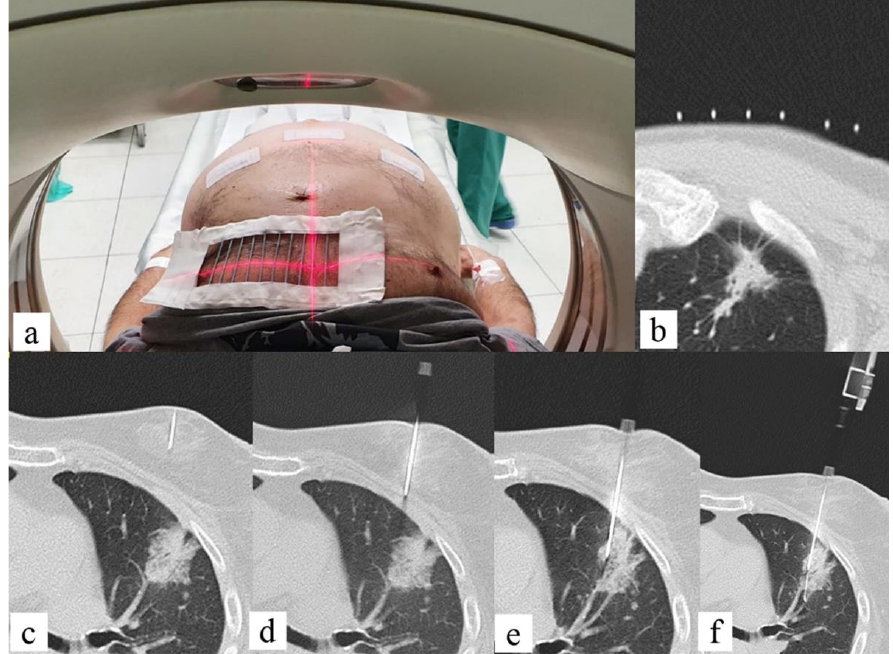
Figure 3. Fifty-six-year-old male with lung lesion: CT guided biopsy. ( a ) Patient is positioned supine depending on the lesion location; the region of interest on the patient thoracic skin is delimitated with a radiopaque grid; ( b ) the entry point on the skin is signed on basis of coordinates given by the intersection of grid markers and CT level; ( c ) the anesthesia needle is left on the skin, and a CT scan is performed to check the correct needle trajectory previously determined; ( d – f ) the anesthesia needle is replaced with a 20 G coaxial needle that is advanced from the entry point to the target point on basis of CT images planning with a “step -by- step” CT guidance technique.